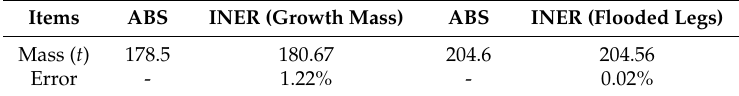
Table 4. Simulation Results Comparison: Growth Mass and Flooded Legs Mass.